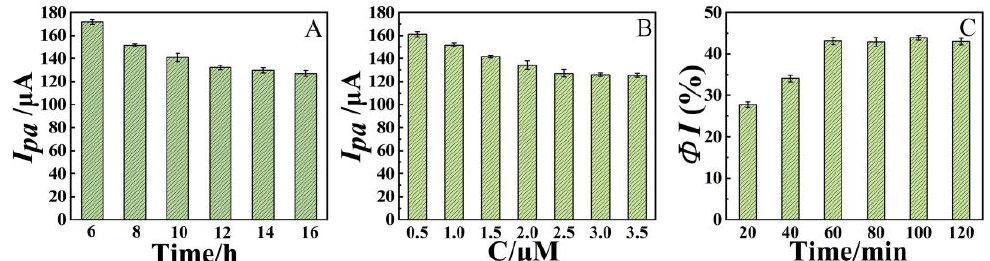
Figure 9. ( A ) Effects of immobilization time of aptamer on I pa , ( B ) Effects of aptamer concentration on I pa , ( C ) Effects of PQ incubation time on ФI . Error bars were obtained as the standard deviation of triple measurements ( n = 3).